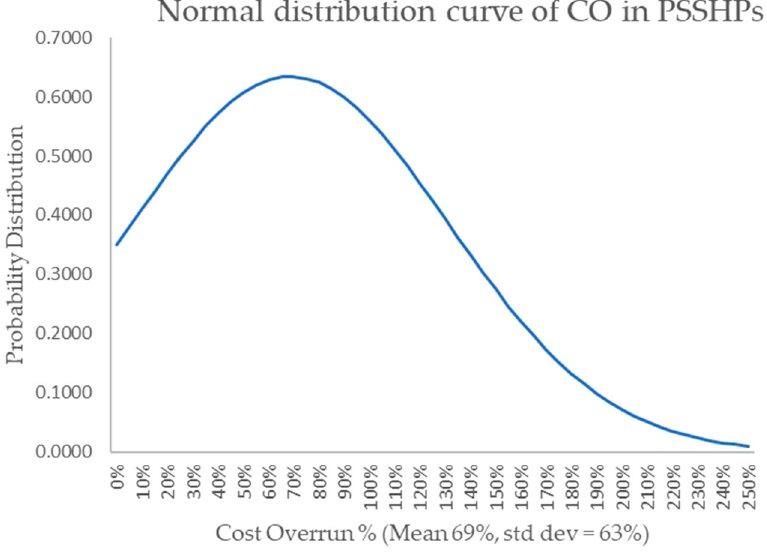
Figure 3. Normal distribution of cost overrun in PSSHPs.